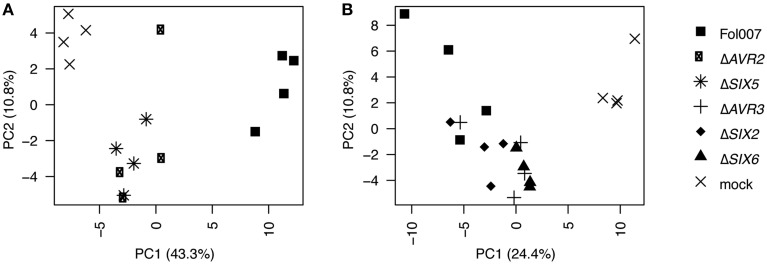
Technical replicates of each treatment cluster along the x-axis. PCA plot based on the normalized proteome data. PC1 is plotted on the x-axis, PC2 is plotted on the y-axis. The PCA analysis was performed with all 16 individual treatments from data set 1 (A) and the 20 treatments from data set 2 (B).